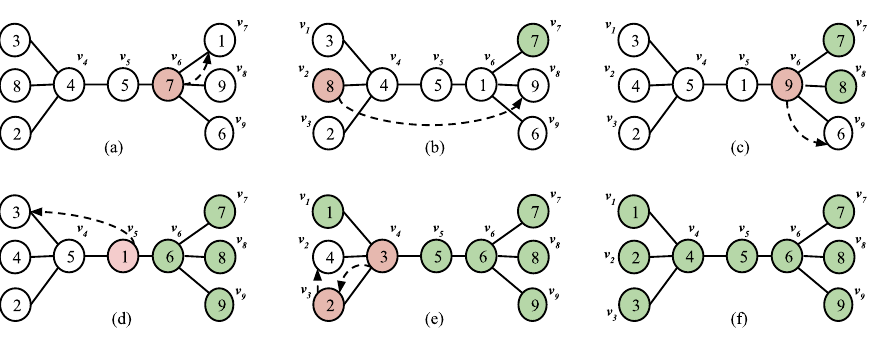
= 7, Swaps = 1. ( b ) S R = 8, Swaps = 4. ( c ) S R min min = 3, Swaps = 1, S R = 2, Swaps = 1. ( f ) All markers are min min